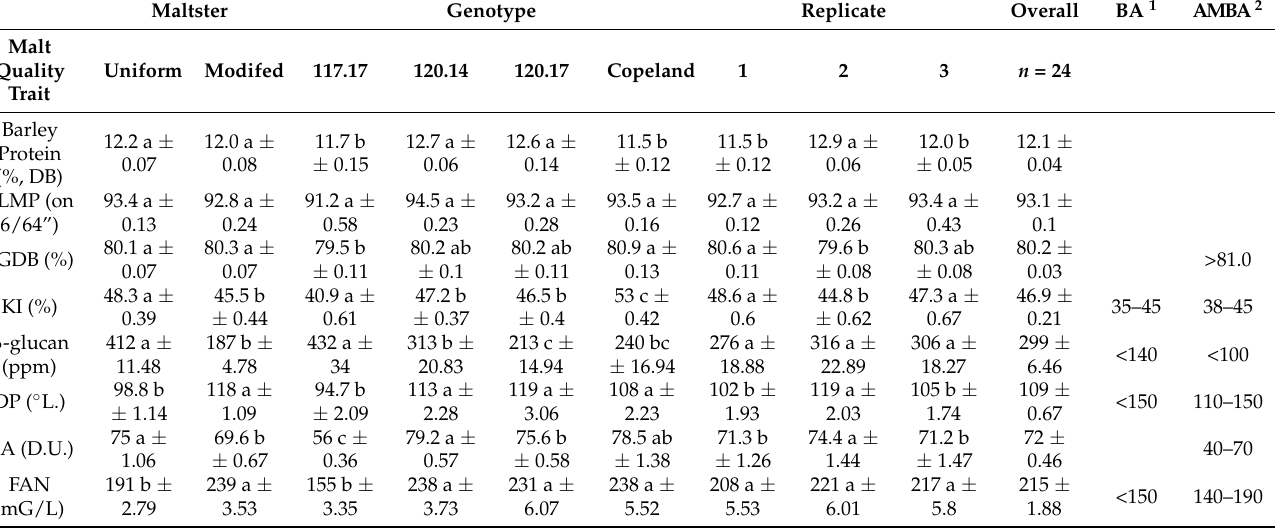
Table 1. Summary statistics, including the mean and the standard error of the mean (SEM) reported for malt quality traits overall, and for each malt method, genotype and replicate, respectively. Malt methods include uniform (all genotypes malted under the same conditions) and modified (genotypes malted according to genotype-dependent malting conditions). Mean separation performed separately for malt method, genotype, and field replicate, using Fisher’s Least Significant Difference (LSD) with Bonferroni-corrected p -values. For the columns in malt method, genotype and replicate, values within each row that do not share a letter are significantly